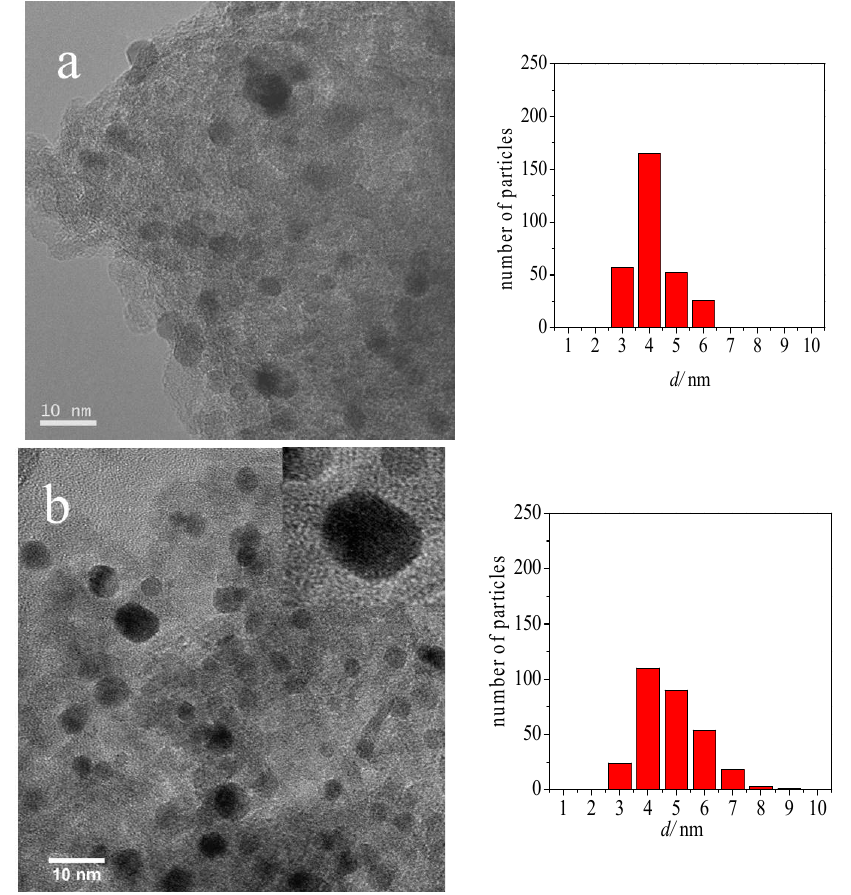
Figure 2. TEM images (left) and particle size distributions (right) of ( a ) Au ‐ DDA/ γ‐ Al 2 O 3 ; and ( b ) Au ‐ DDA/ γ‐ Al 2 O 3 (O 3 8 h). The inset in the TEM image ( b ) shows the crystallinity of an Au nanoparticle.